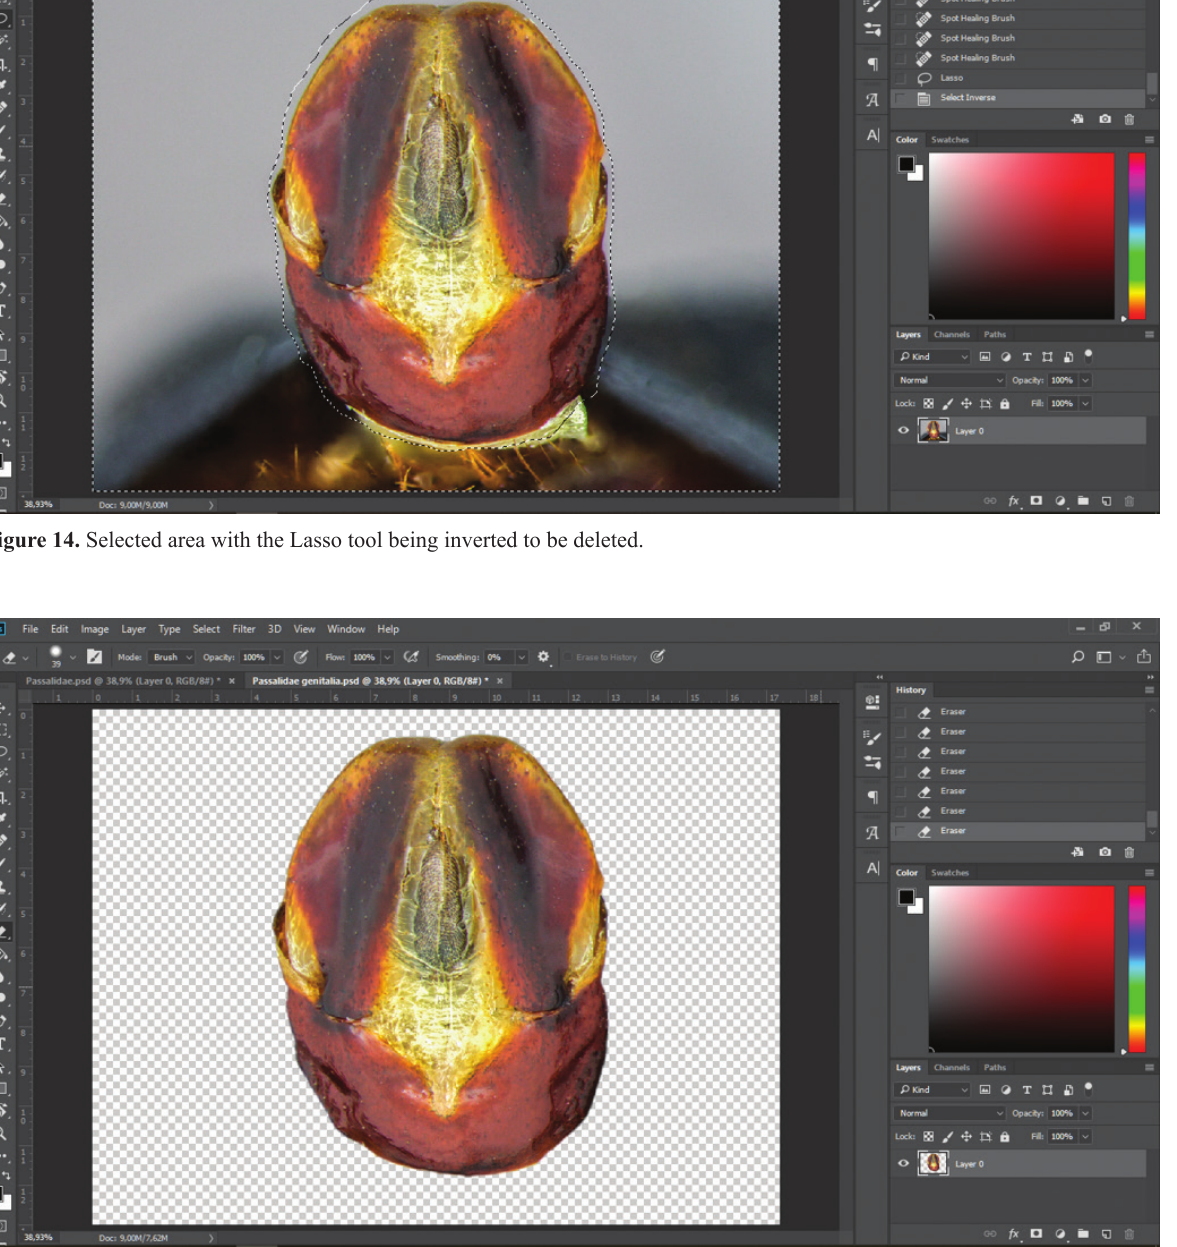
Figure 15. Background completely removed using the Eraser